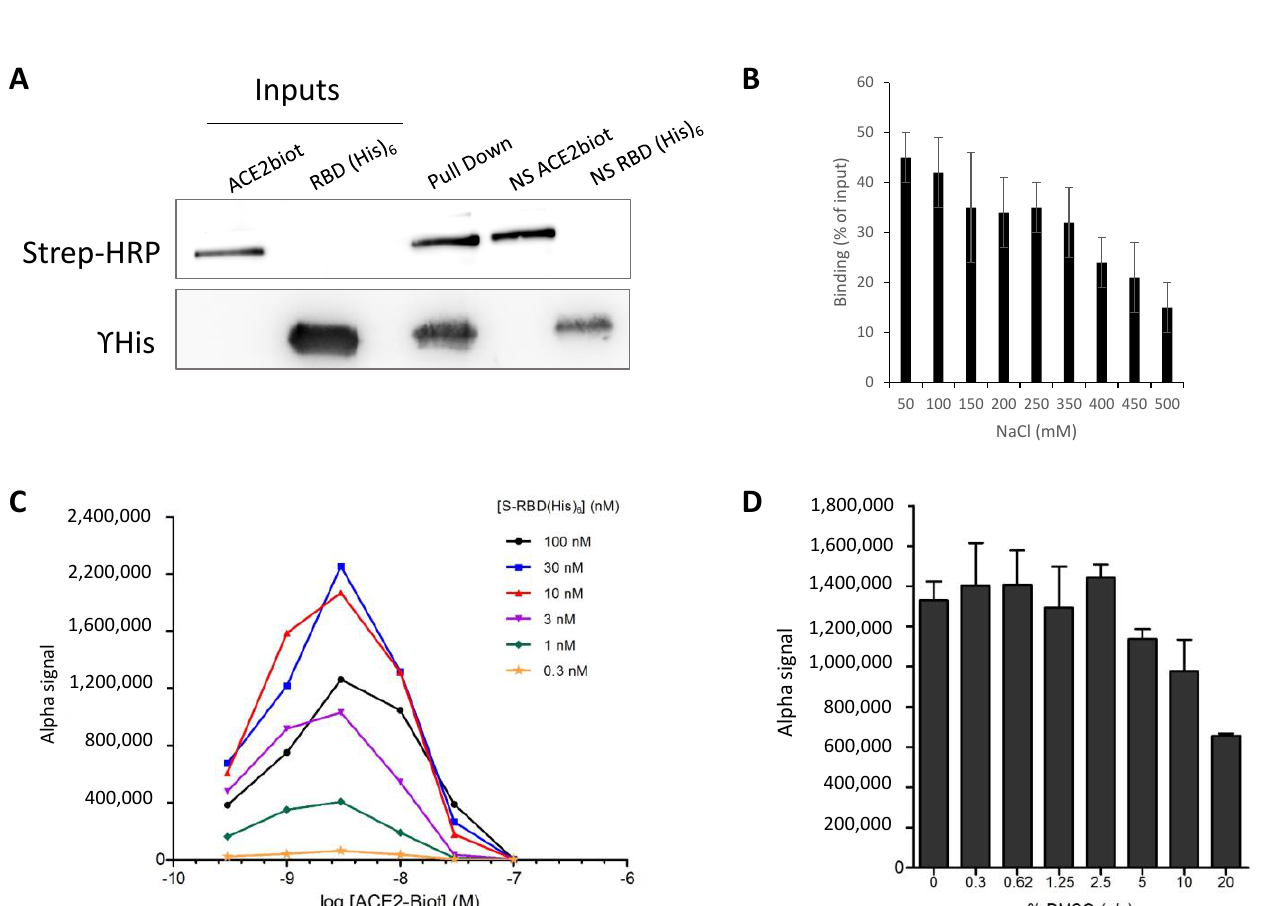
Figure 2. In vitro monitoring of the SARS-CoV-2 S-RBD/ACE2 interaction. SARS-CoV-2 S-RBD(His) 6 and human ACE2-Biot interaction have been first monitored by typical pull down assay using streptavidin coupled magnetic beads ( A ) using 500 ng of each protein. Input, co-precipitated proteins (pull down) and non-specific binding of each partner on beads are reported in the figure. Pull downs have been performed at different NaCl concentration and the percentage of retained S-RBD protein is reported in ( B ). Data were obtained from at least three independent experiments and are reported as means ± SD. The S-RBD/ACE2 complex has been further analyzed using AlphaLISA assay. Cross titration experiments of ACE2-Biot (0.3 to 100 nM) against S-RBD(His) 6 (0.3 to 100 nM) using anti-6X His acceptor beads and streptavidin donor acceptor beads are reported in ( C ). Evaluation of the tolerance for dimethyl sulfoxide (DMSO) has been performed as describe above with addition of 0.3 to 20% ( v / v ) of DMSO in the ACE2-Biot/S-RBD(His) 6 binding step. In these conditions, binding data with DMSO were compared to the control condition without DMSO ( D ). Data were obtained from at least two independent experiments and are reported as means ±